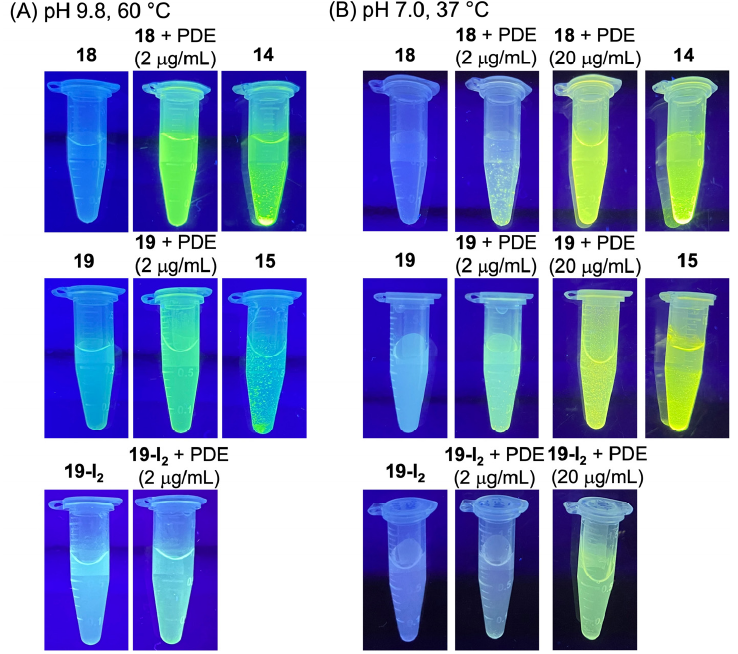
Figure 7. Visualization (UV illumination) of samples. ( A ) Treatment at pH 9.8 and 60 °C for 24 h. Left column—no enzyme with 18 , 19 , and 19-I 2 (20 μ M). Middle column—treatment of 18 , 19 , and column—no enzyme with 18 , 19 , and 19-I 2 (20 µ M). Middle column—treatment of 18 , 19 , and 19-I 2 19-I 2 (20 μ M) with PDE (2 μ g/mL). Right column— 14 and 15 (20 μ M) in PDE buffer (positive con- trols). ( B ) Treatment under physiological condition (pH 7.0 and 37 °C) for 24 h. First column—no (20 µ M) with PDE (2 µ g/mL). Right column— 14 and 15 (20 µ M) in PDE buffer (positive controls). enzyme with 18 , 19 , and 19-I 2 (20 μ M). Second or third column—treatment of 18 , 19 , and 19-I 2 (20 ( B ) Treatment under physiological condition (pH 7.0 and 37 ◦ C) for 24 h. First column—no μ M) with PDE (2 μ g/mL) or PDE (20 μ g/mL), respectively. Fourth column— 14 and 15 (20 μ M) in PDE buffer (positive controls).